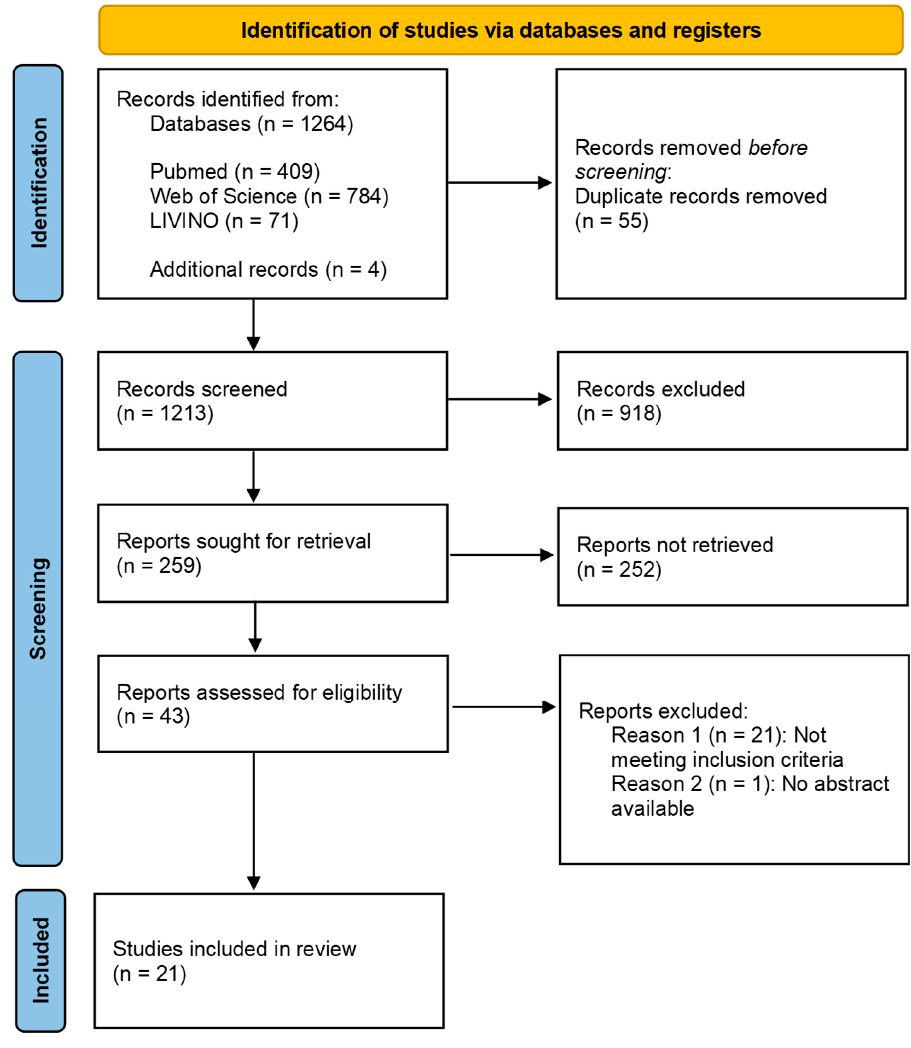
Figure 1. PRISMA 2020 flow diagram [7].